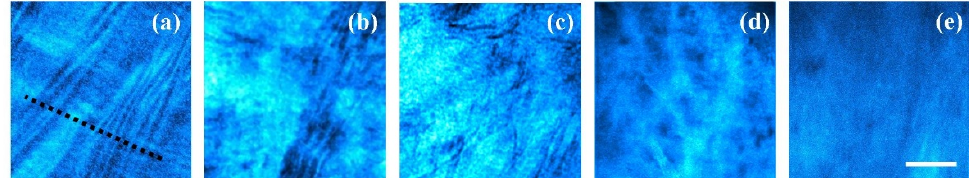
Figure 4. SHG images corresponding to the temporal evolution of a human corneal edema. ( a ) Control cornea (time point 0); ( b – d ) edema progression (time points 1–3); ( e ) final severe edematous cornea (i.e., opaque tissue, time point 4). Bar length = 50 μm.